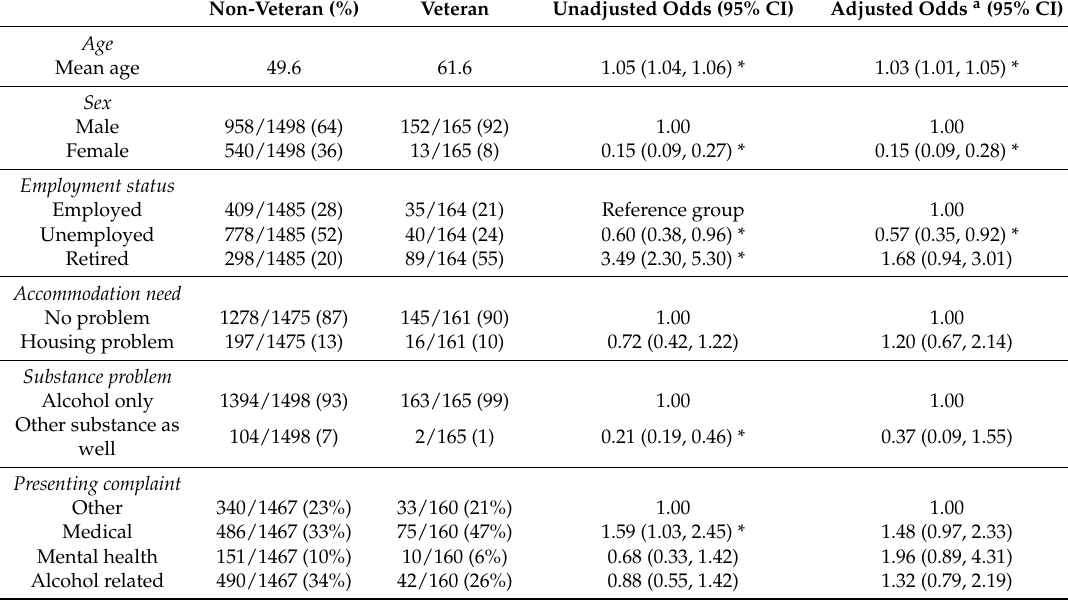
Table 1. Demographic characteristics and presenting complaints between veterans and non